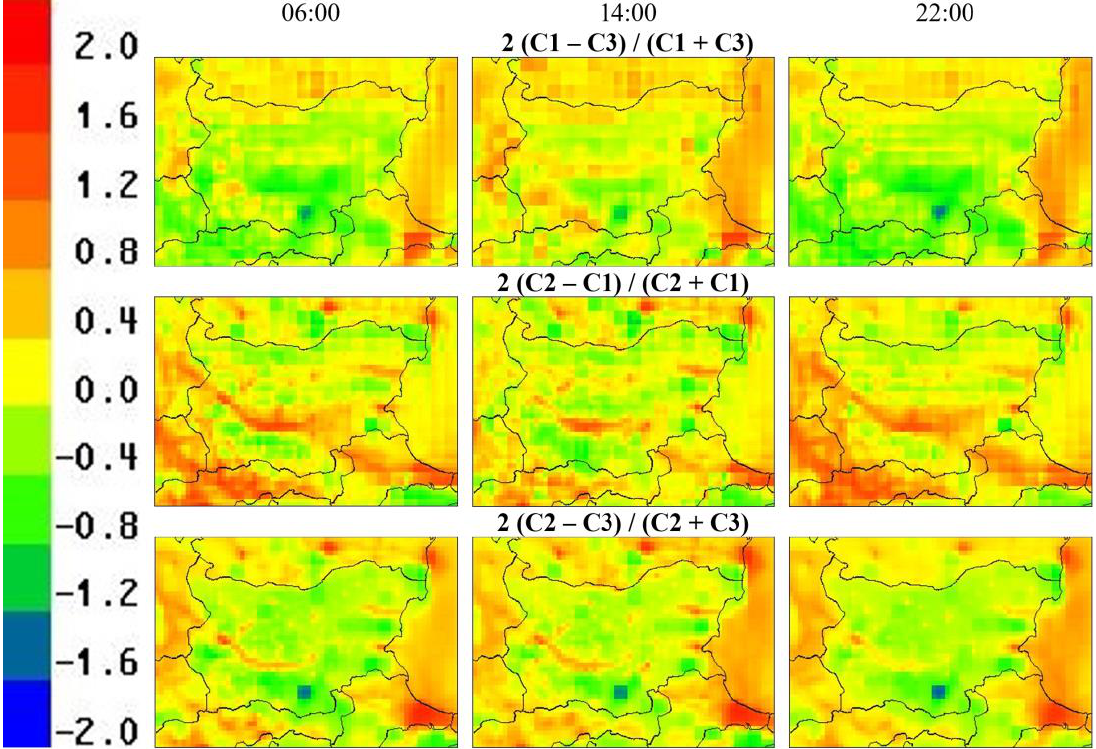
Figure 3. Annually averaged relative differences of the surface concentrations of NO 2 between cases C1 and C3, C2 and C1, C2 and C3 respectively.